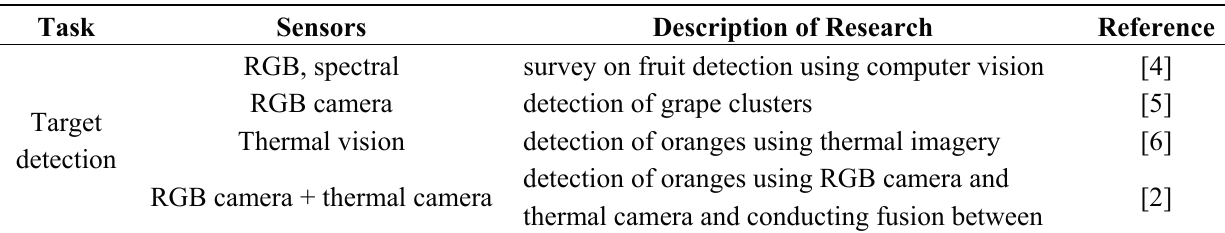
Table 1. Examples of various precision agriculture topics of research in the last three